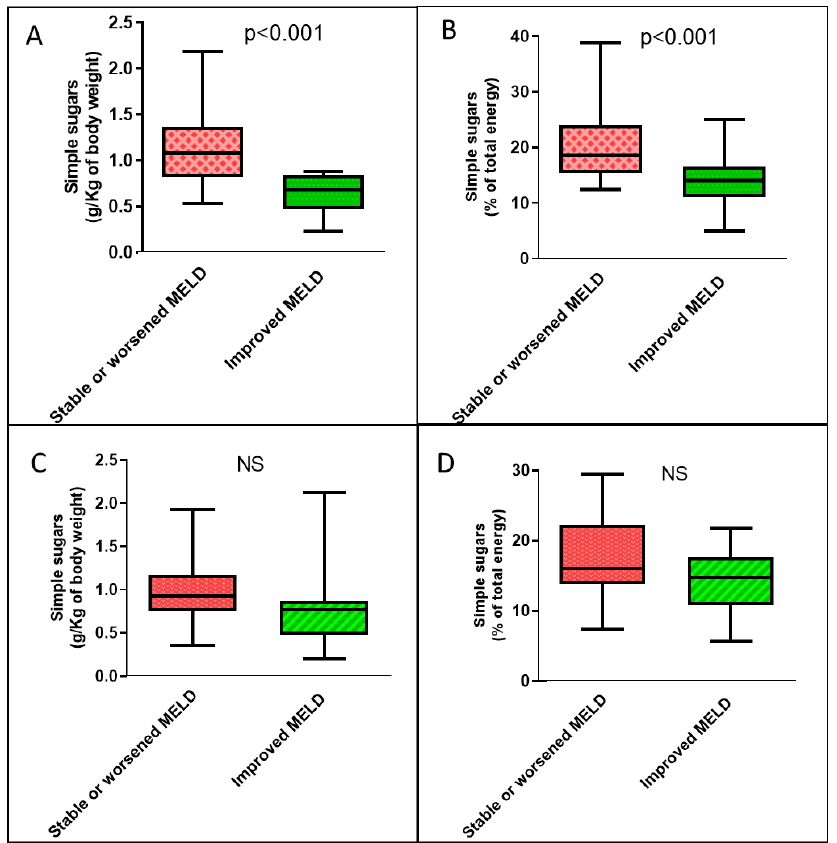
Figure 3. Boxplots of the amounts of simple sugars consumed each day according to temporal changes in the MELD score by cirrhotic patients according to visceral adipose tissue. ( A ) Dietary simple sugars intake expressed as g/Kg of body weight among patients with high VATI. ( B ) Dietary simple sugars intake expressed as a percentage of total energy among patients with high VATI. ( C ) Dietary simple sugars intake expressed as g/Kg of body weight among patients with low VATI. ( D ) Dietary simple sugars intake expressed as a percentage of total energy among patients with low VATI. NS: not